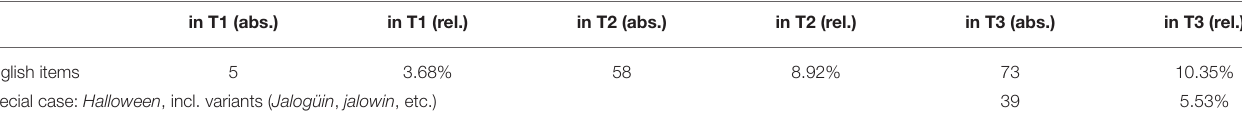
TABLE 4 | English and English-induced elements in the tweets. in T1